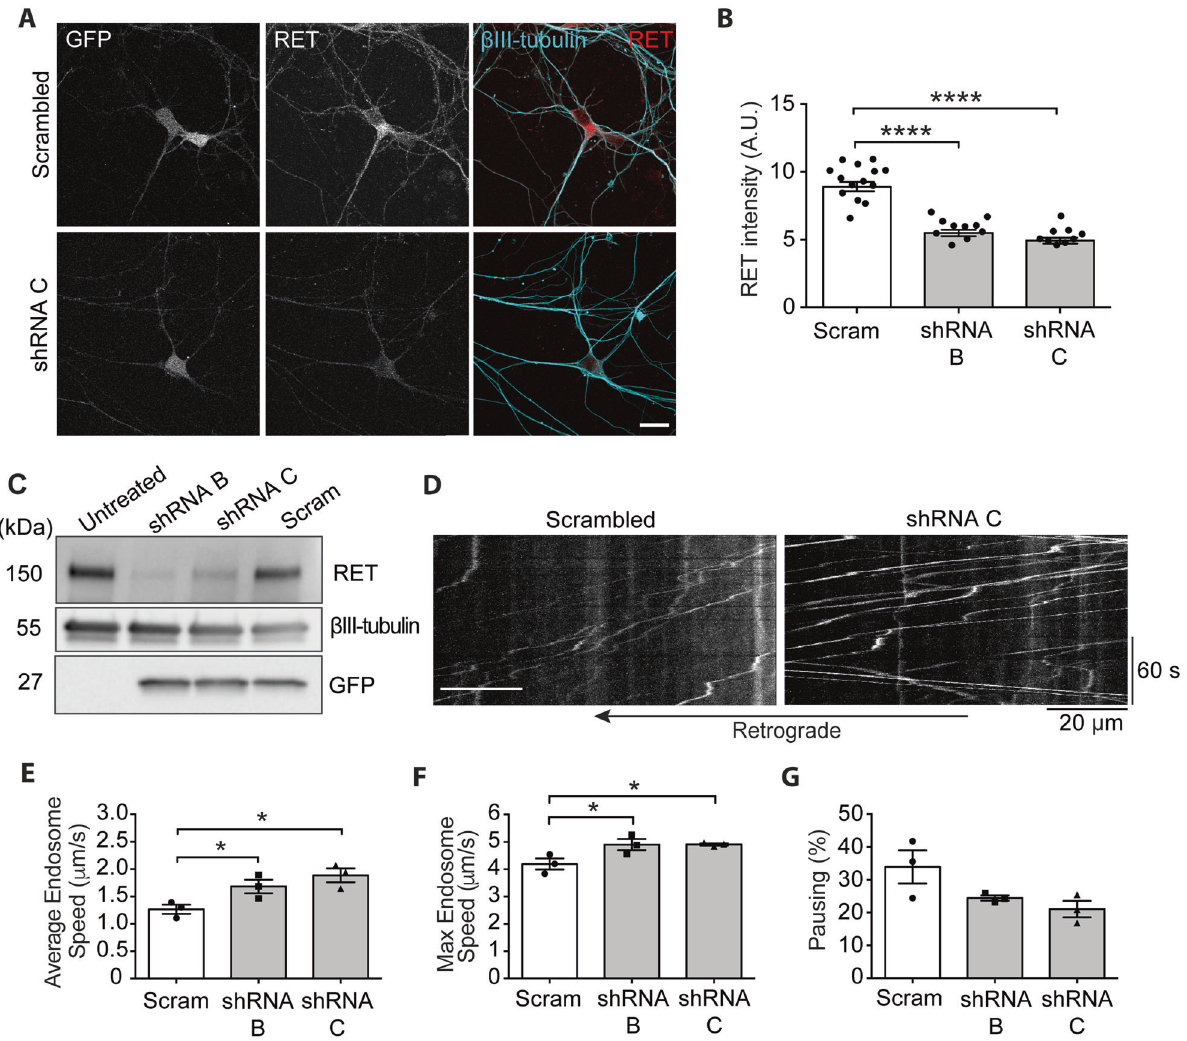
Fig. 4 RET knockdown mimics the effect of pharmacological RET inhibition on axonal transport. A Representative images of RET, β III- tubulin and GFP staining in primary MN cultures transduced with scrambled control (Scram) or RET-targeting shRNA (shRNA C). Scale bar, 20 µm. B Quanti fi cation of RET signal using a β III-tubulin mask, as shown in A . **** p < 0.0001 and determined by a one-way ANOVA. C Representative western blot showing RET, GFP and β III-tubulin levels in primary MN lysates after transduction with lentiviral particles expressing RET-targeting shRNA B, C and scrambled control (Scram). D Representative kymographs from RET knockdown transport experiments. E – G Primary ventral horn neurons after RET knockdown showing the E mean signalling endosome transport speed (* p <